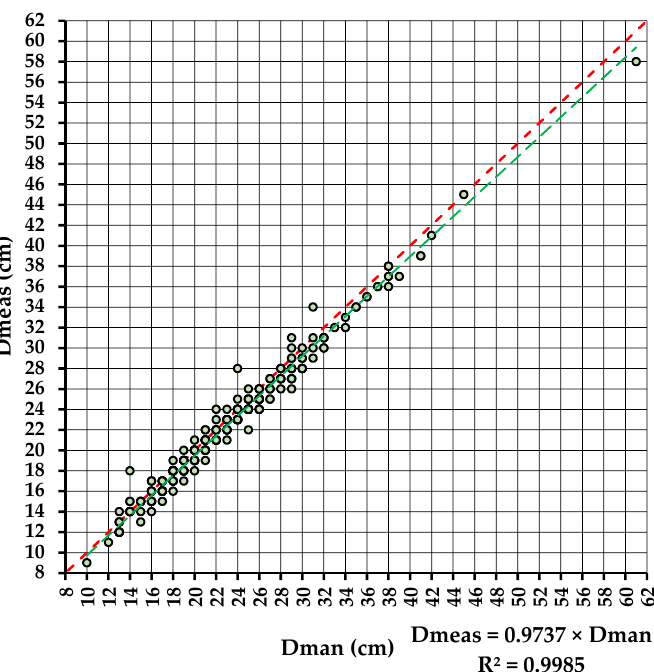
Figure 6. Agreement between the methods in terms of diameter measurement (E1): ( a ) Absolute frequency of differences ( Δ D) between Dman and Dmeas; ( b ) Bland-Altman plot showing the dif- ferences plotted against the mean of paired measurements, the bias (green line), and the lower and upper limits of agreement (red dashed lines).